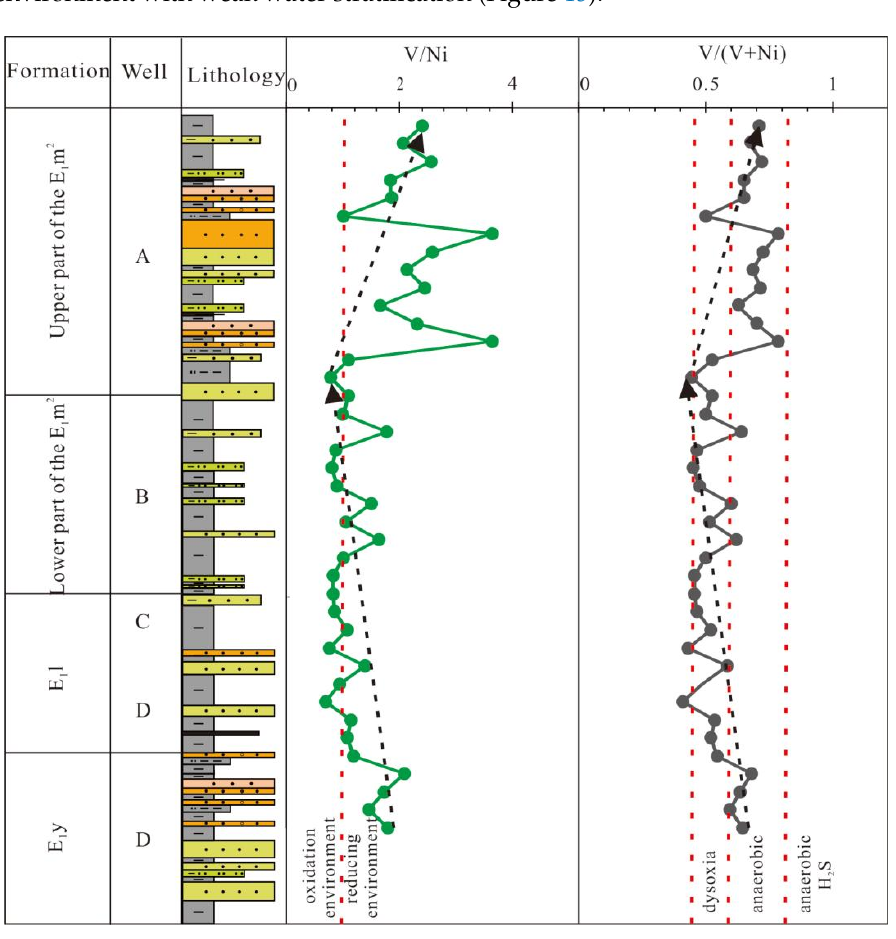
The average V/Ni ratio of the Paleocene in the West Lishui Sag was 1.54, of which those greater than 1 accounted for 75% of the total data. The V/Ni ratios of the E 1 m 2 were 1~3.64, with an average of 2.32, and the V/(V + Ni) ratios were 0.5~0.78, with an average of 0.68. The V/Ni ratios of the E 1 l 1 were 0.69~1.79, with an average of 1.05, which generally indicates a reducing environment. The ratios less than 1 may be caused by regression or terrigenous inputs. The V/(V + Ni) ratios were 0.41~0.64, with an average of 0.50, indicating that the sedimentary water body of the E 1 l 1 was in an oxygen-poor environment with weak water stratification. The V/Ni ratios of the E 1 l 2 were 1.19~2.09, with an average of 1.65, indicating a reducing environment. The V/(V + Ni) ratios were 0.54~0.68, with an average of 0.62, indicating that the sedimentary water body of the E 1 l 2 was in an anaerobic environment with weak water stratification (Figure 15).